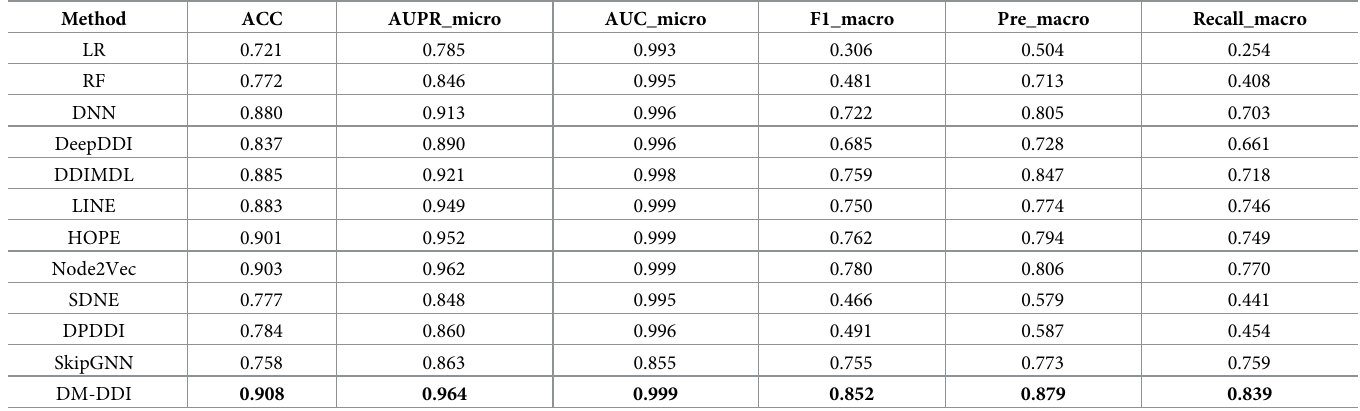
Table 3. Performance of our model against competitive approaches.